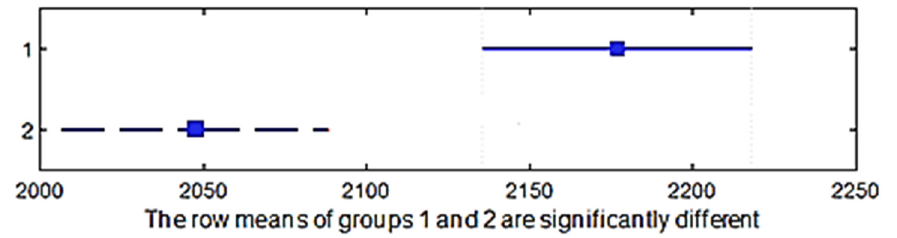
Figure 14. Confidence intervals of the air permeability of different raw materials.